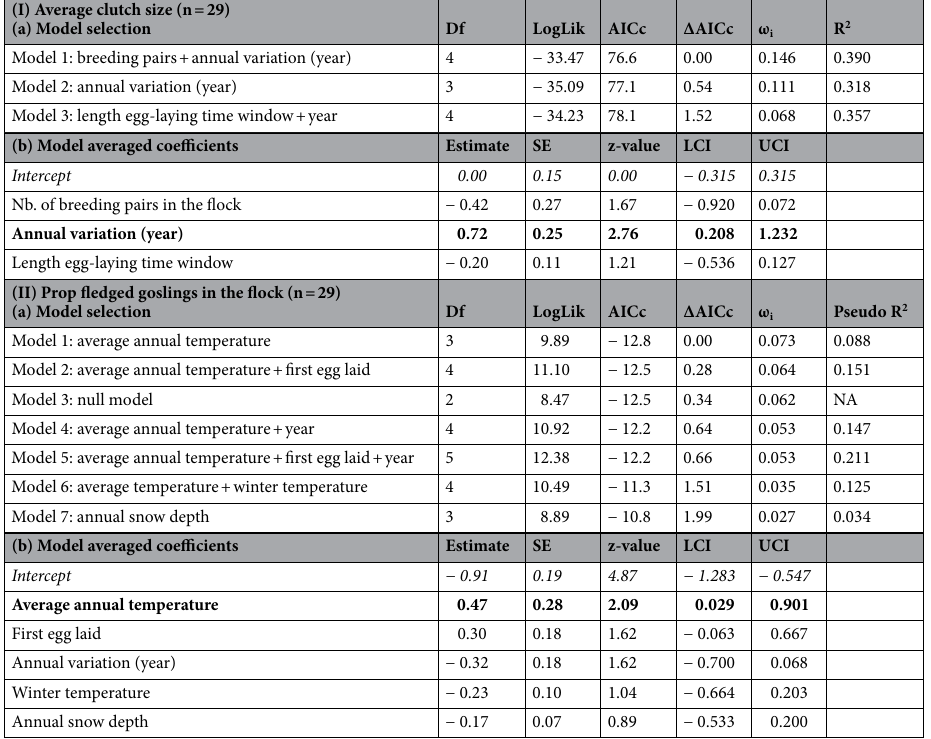
Table 3. Linear effects model for (I) average clutch size in the flock; and (II) beta regression model for the proportion of fledged goslings per season over 29 years (1990–2018) in the Alm valley, Austria, in relation to the timing of breeding, the number of pairs attempting to breed, weather and annual variation. (a) Model selection results compared by Akaike’s Information Criterion for small samples (AICc) against each other and model weight (ω i ) presented up to ΔAIC c < 2.0; and (b) Model-averaged coefficients from a set of 3 models for the first egg laid; and, from a set of 7 models from the proportion of fledged goslings with ΔAICc < 2.0 presented as estimated values ± (unconditional) SE, lower and upper 95% CIs; confidence intervals of parameter estimates not including zero (i.e., considered significant) are displayed in bold. Note that all quantitative input variables were scaled and centred. Null model ranked (I) 56th [Akaike’s information criterion corrected for small sample size (AICc) = 85.7, ΔAICc = 9.14]; and, (II) 3rd (AICc = − 12.5, ΔAICc = 0.34). Model weights based on complete list of candidate models (n =